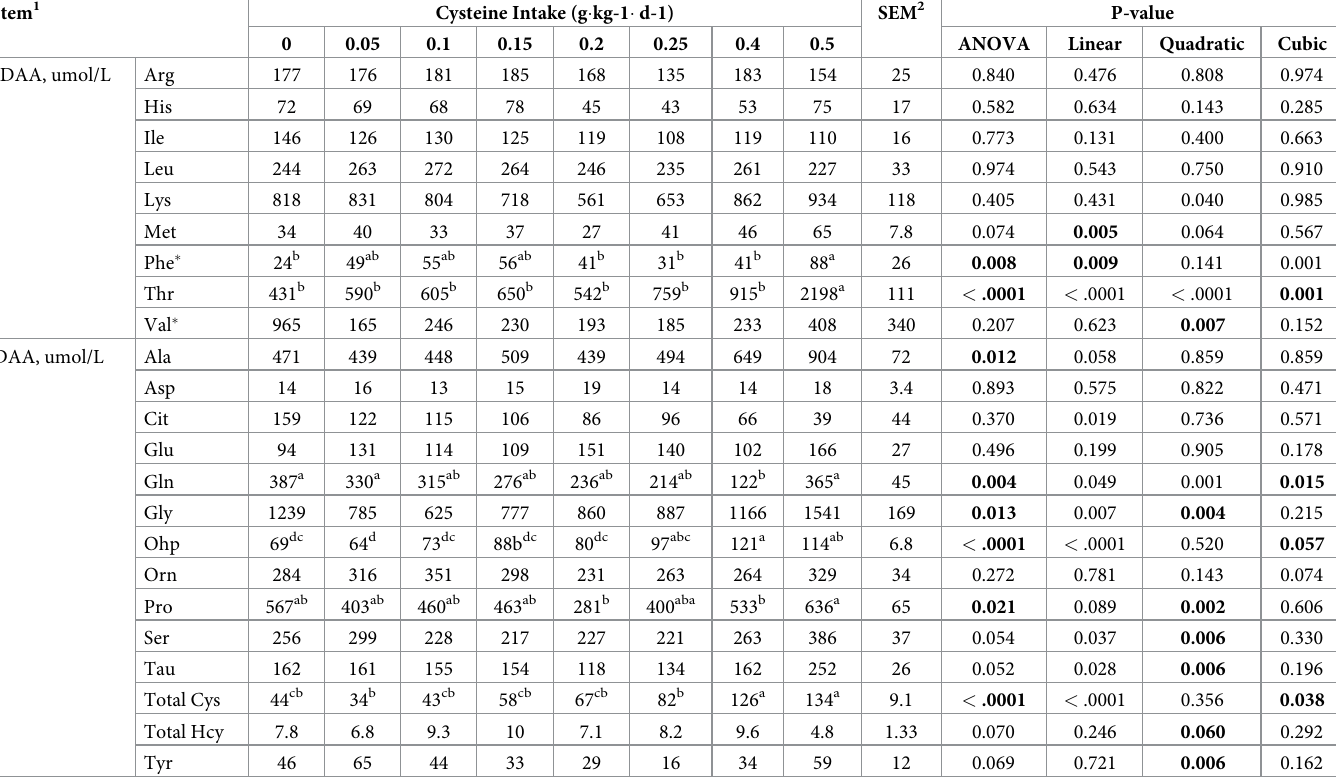
Table 3. Plasma amino acid concentrations (lsmeans) in piglets receiving total enteral nutrition after L-[1- 14 C]Cys infusion. Item 1